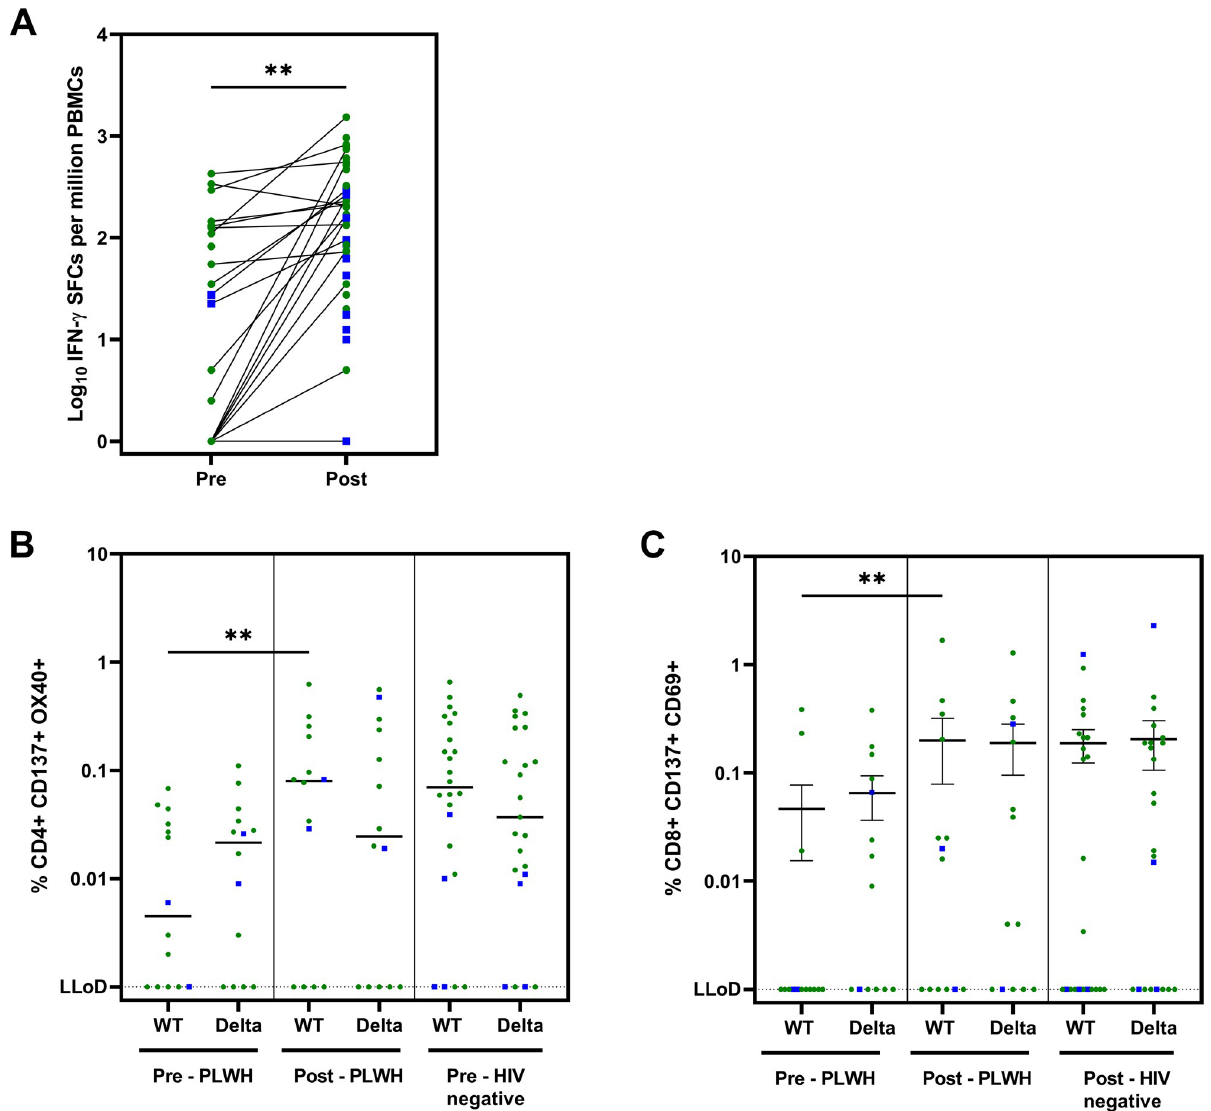
Fig 3. Cellular immune responses against SARS-CoV-2 in subgroup participants (PLWH). (A) Cellular immune response to wild-type spike by ELISpot assay (Pre, n = 23; Post, n = 45): IFN- γ SFCs after subtraction of MOG. Statistics performed using Mann–Whitney U test: p = 0.002. Negative responses: Pre, 8; Post, 5. (B) Cellular immune response to wild-type and Delta spike in AIM assay ( n = 14): percentage of CD4+ CD137+ OX40+ T- cells after subtraction of DMSO. Dotted line shows the LLoD at 0.001%. Statistics between pre- and post-vaccination for WT in PLWH performed using Wilcoxon matched-pairs signed rank test ( p = 0.005); pre- and post-vaccination for Delta: ns. Statistics between PLWH and controls with Mann– Whitney U test: not significant. (C) Cellular immune response to wild-type and Delta spike in AIM assay ( n = 14): percentage of CD8+ CD137+ CD69 + T-cells after subtraction of DMSO. Dotted line shows the LLoD at 0.001%. Statistics performed using Wilcoxon matched-pairs signed rank test ( p = 0.008); pre- and post-vaccination for Delta: ns. Statistics between PLWH and controls with Mann–Whitney U test: not significant. Green circles: mRNA vaccines; blue squares: vector-based vaccines. Pre: before vaccination; Post: 4–6 weeks after second vaccination. AIM, activation-induced marker; BAU, binding antibody units; cART, combination antiretroviral therapy; DMSO, dimethyl sulfoxide; ELISpot, enzyme-linked immune absorbent spot; GMC, geometric mean concentration; INF- γ , interferon- γ ; LLoD, lower limit of detection; MOG, myelin oligodendrocyte glycoprotein; PBMC, peripheral blood mononuclear cell; PLWH, people living with HIV; SFC, spot-forming cell; WT, wild type.